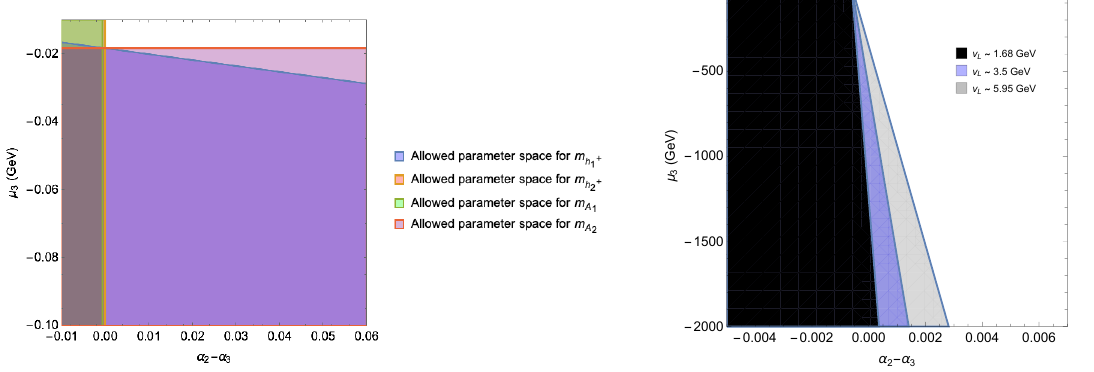
Figure 5 . Parameter space spanned by µ 3 and α 2 − α 3 . Left Panel: allowed regions (shaded) are obtained considering restrictions on the physical charged and neutral scalar states, requiring m > 80 GeV, m , m A > 0 and m A > 80 GeV [55]. Right Panel: surviving allowed parameter h ± 1 h ± 2 1 2 space from Higgs mass criteria for different values of v , as given in the L